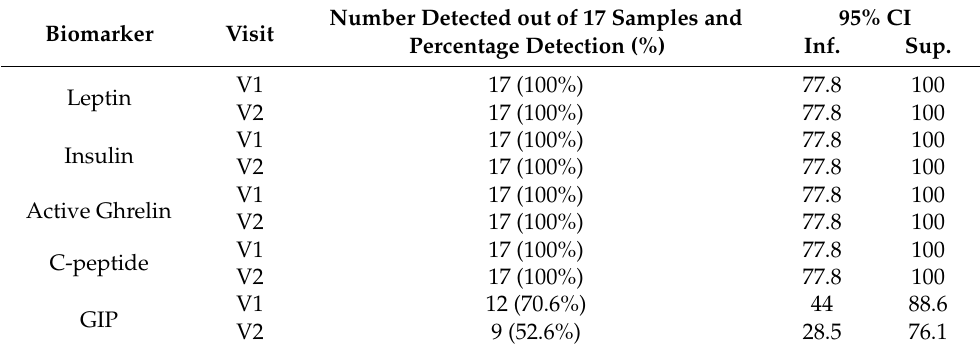
Table 2. Percentage (%) detection of metabolic proteins in the tear samples.